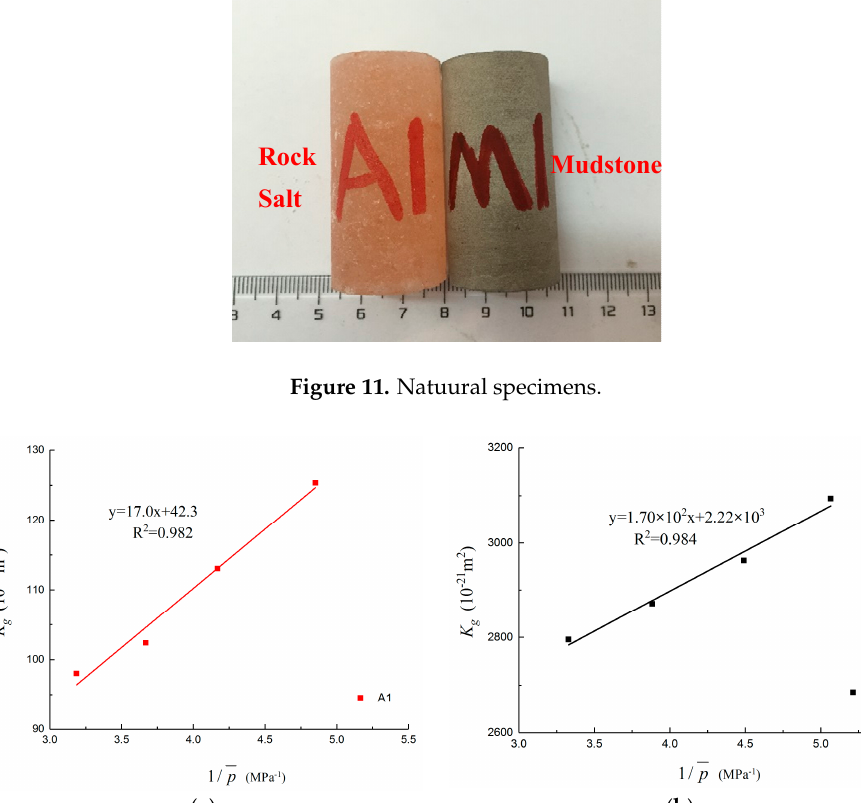
Figure 12. Natural specimen permeability results. ( a ) Natural pure rock salt; ( b ) natural pure rock salt. Note: We define the salt rock with high salt content as pure salt rock (>95%, both for the natural rock salt and synthetic rock salt).